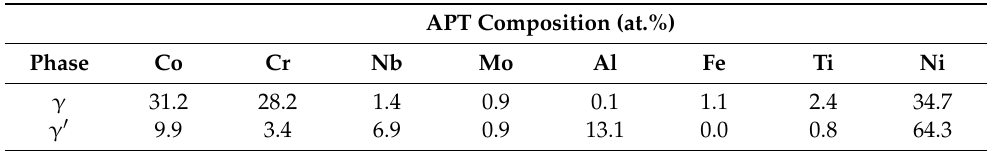
Table 2. Chemical composition of the γ and γ (cid:48) phases in VDM ® Alloy 780 samples measured by atom-probe tomography. Data from